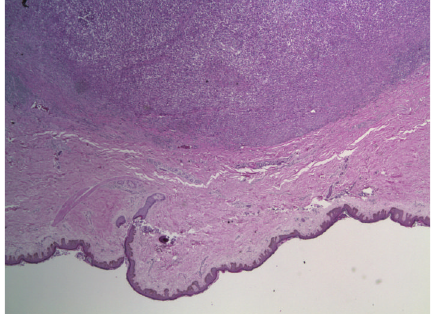
Figure 6: Abdominal wall biopsy specimen: poorly differentiated neoplastic cells with abundant cytoplasm with hyperchromatic nuclei. No gland or sheets of squamous cell formation.